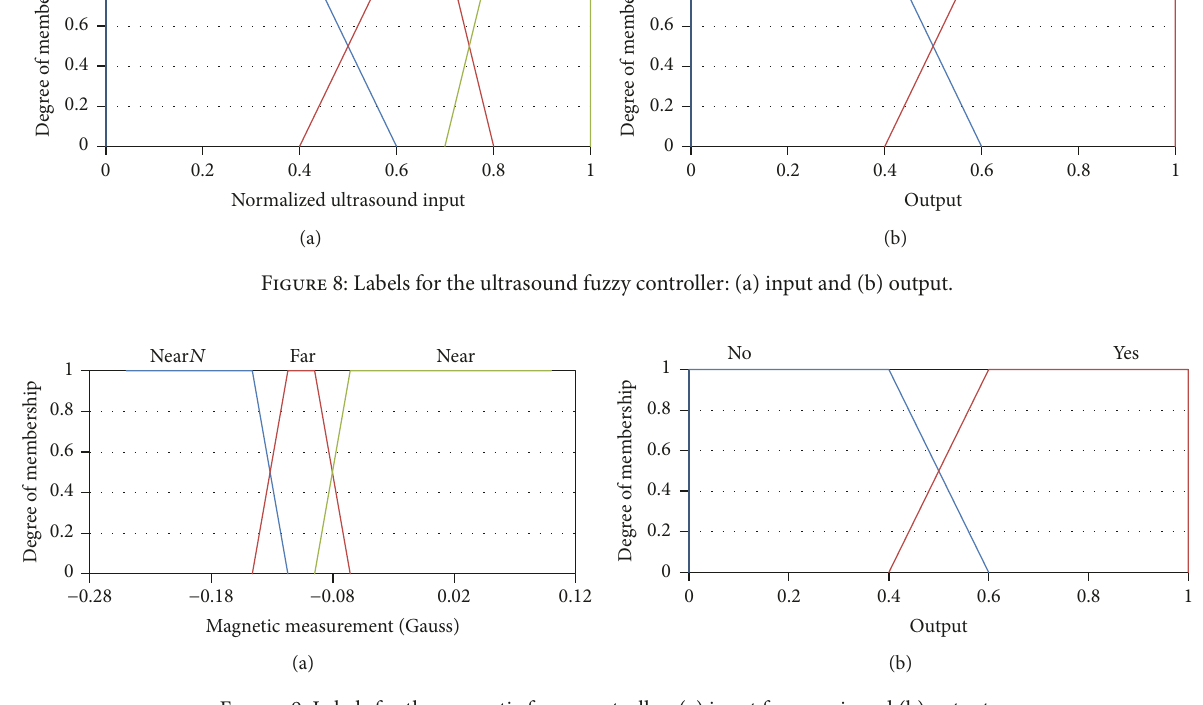
Figure 9: Labels for the magnetic fuzzy controller: (a) input for an axis and (b) output.